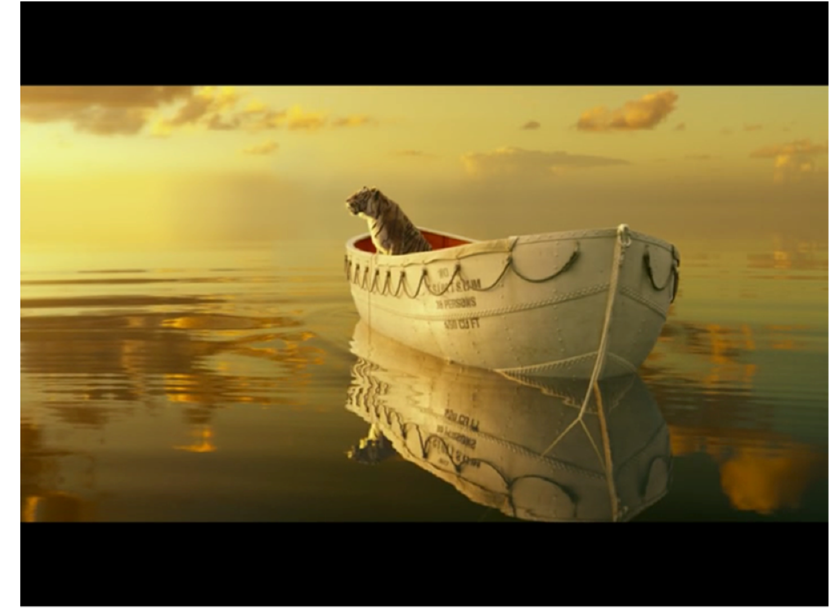
Figure 11. The tiger Richard Parker contemplates his world.